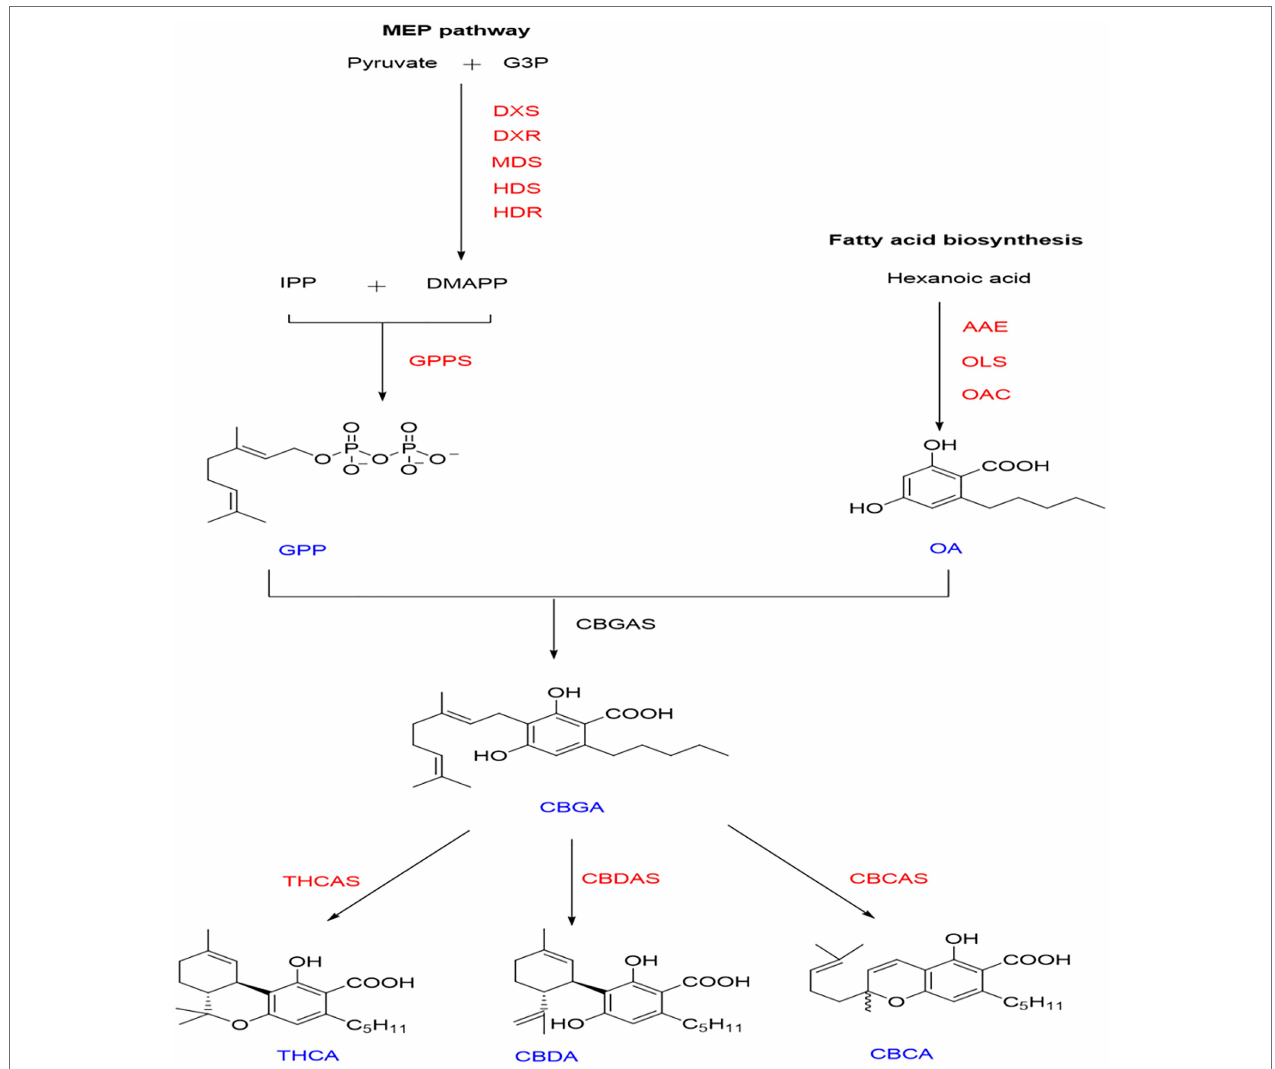
FIGURE 1 | Synthetic pathway of cannabinoids. Intermediates and final products are shown in blue. Enzyme names are shown in red. Fatty acid pathway—AAE, Acyl activating enzyme; OAC, Olivetolic acid cyclase; and OLS, Olivetol synthase. Methylerythritol phosphate (MEP) pathway—DXS, 1-deoxy-d-xylulose 5 phosphate DXP synthase; DXR, DXP reductase; MDS, 2-C-methyl-pyrophosphate synthase; HDS, (E)-4-Hydroxy-3-methyl-but-2-enyIpyrophosphate (HMB-PP) synthase; HDR, HMB-PP reductase; and GPPS: Geranyl diphosphate synthase. Intermediates and final products—GPP, Geranyl diphosphate; OA, Olivetolic acid; CBGA, Cannabigerolic acid; THCA, Δ 9-Tetrahydrocannabinolic acid A; CBDA, Cannabidiolic acid; and CBCA, Cannabichromenic